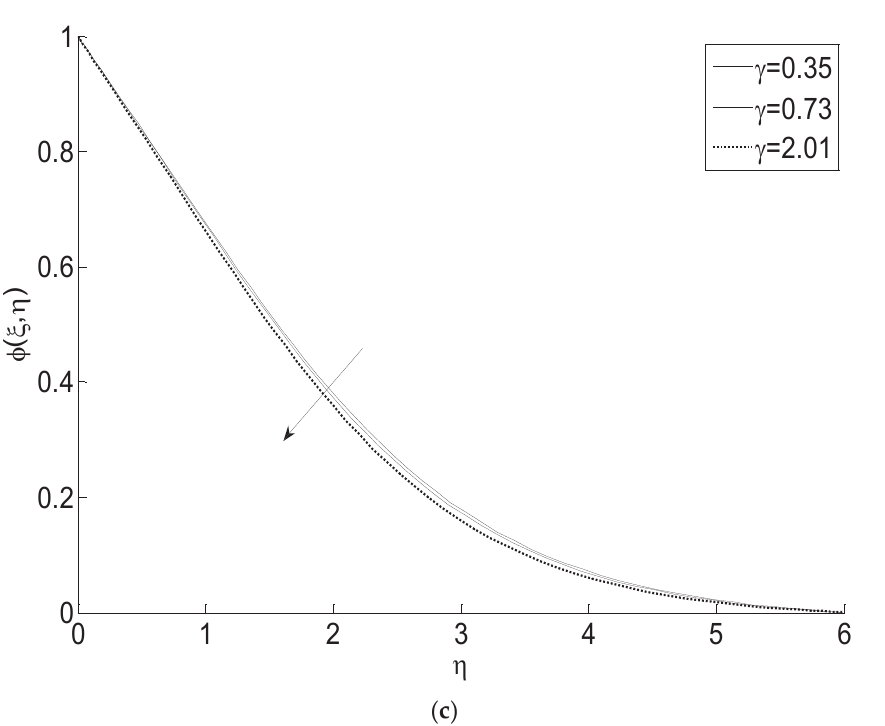
Figure 3. ( a – c ) Velocity, temperature, and concentration profiles, respectively, with different inertia parameters at ξ = 1.0, n = 1.0, Sc = 1.0, N = 1.0, f w = 0.0, κ = 0.5, and Nt = 1.0.